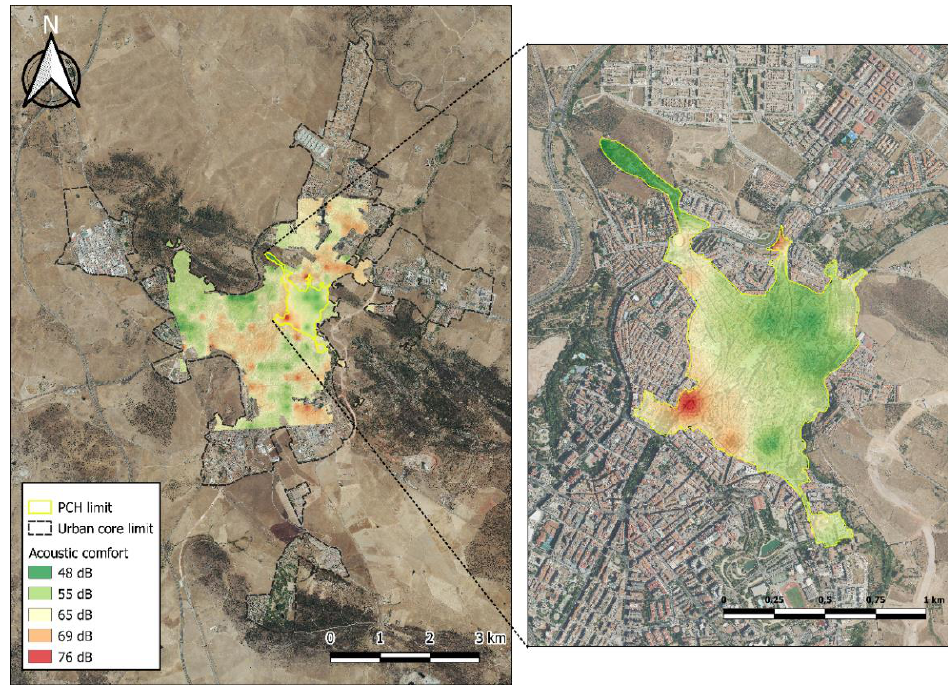
Figure 8. Acoustic comfort comparison.